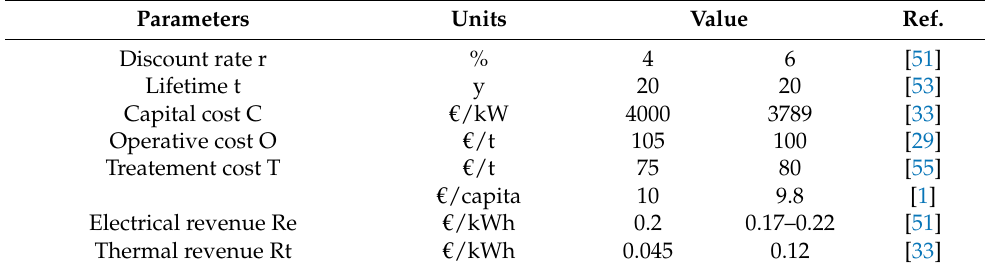
Table 6. Inputs for LCOW calculation.